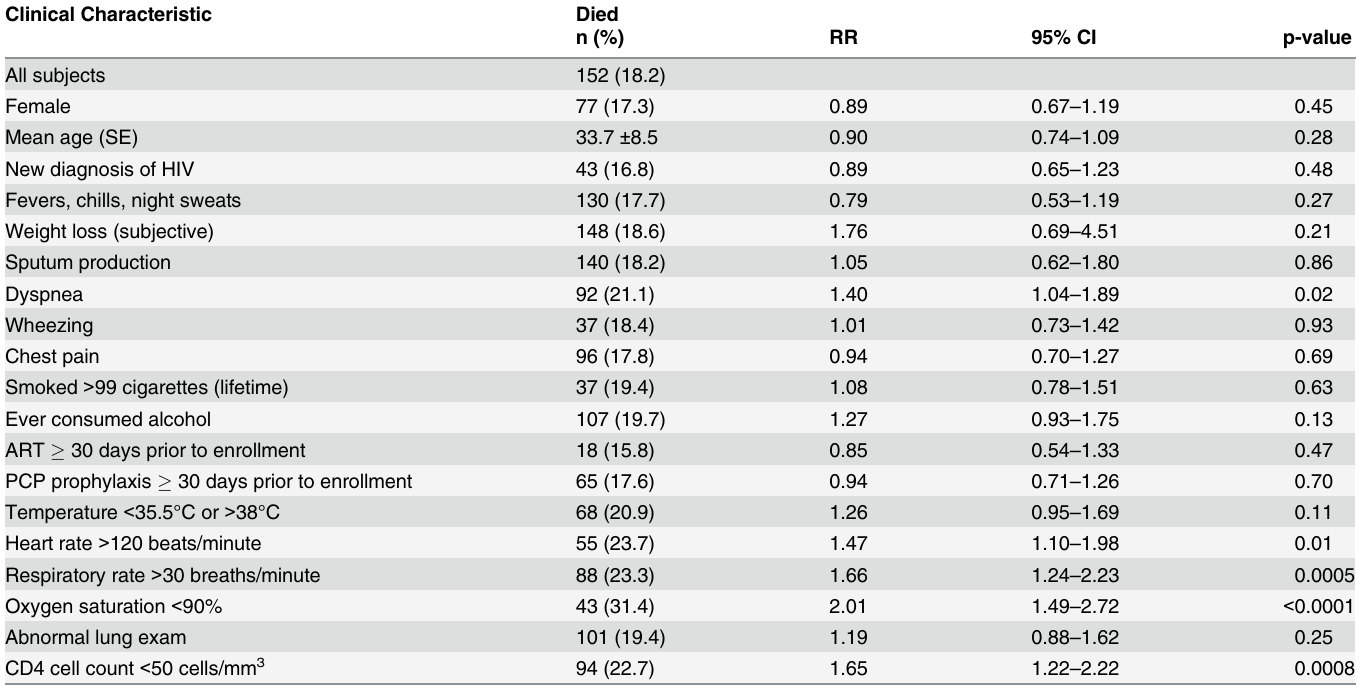
Table 2. Univariate analysis of the association between selected clinical characteristics and 30-day mortality. Clinical